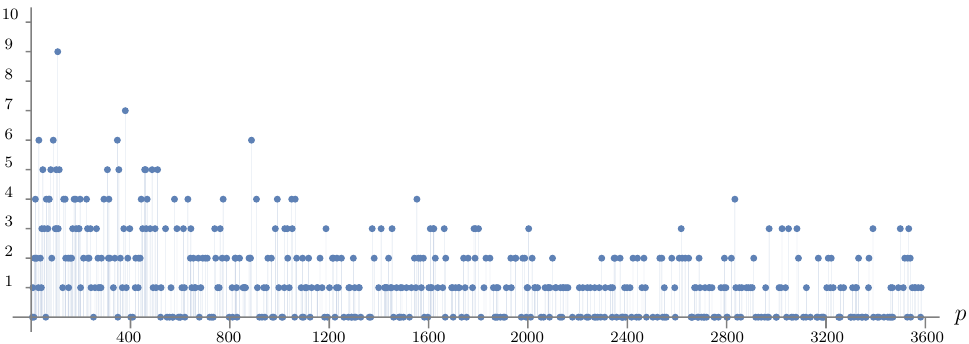
Figure 16 . The residual factorisations for AESZ34 after the factorisations for ’ = (cid:0) 1 = 7 and ’ = ’ (cid:6) have been